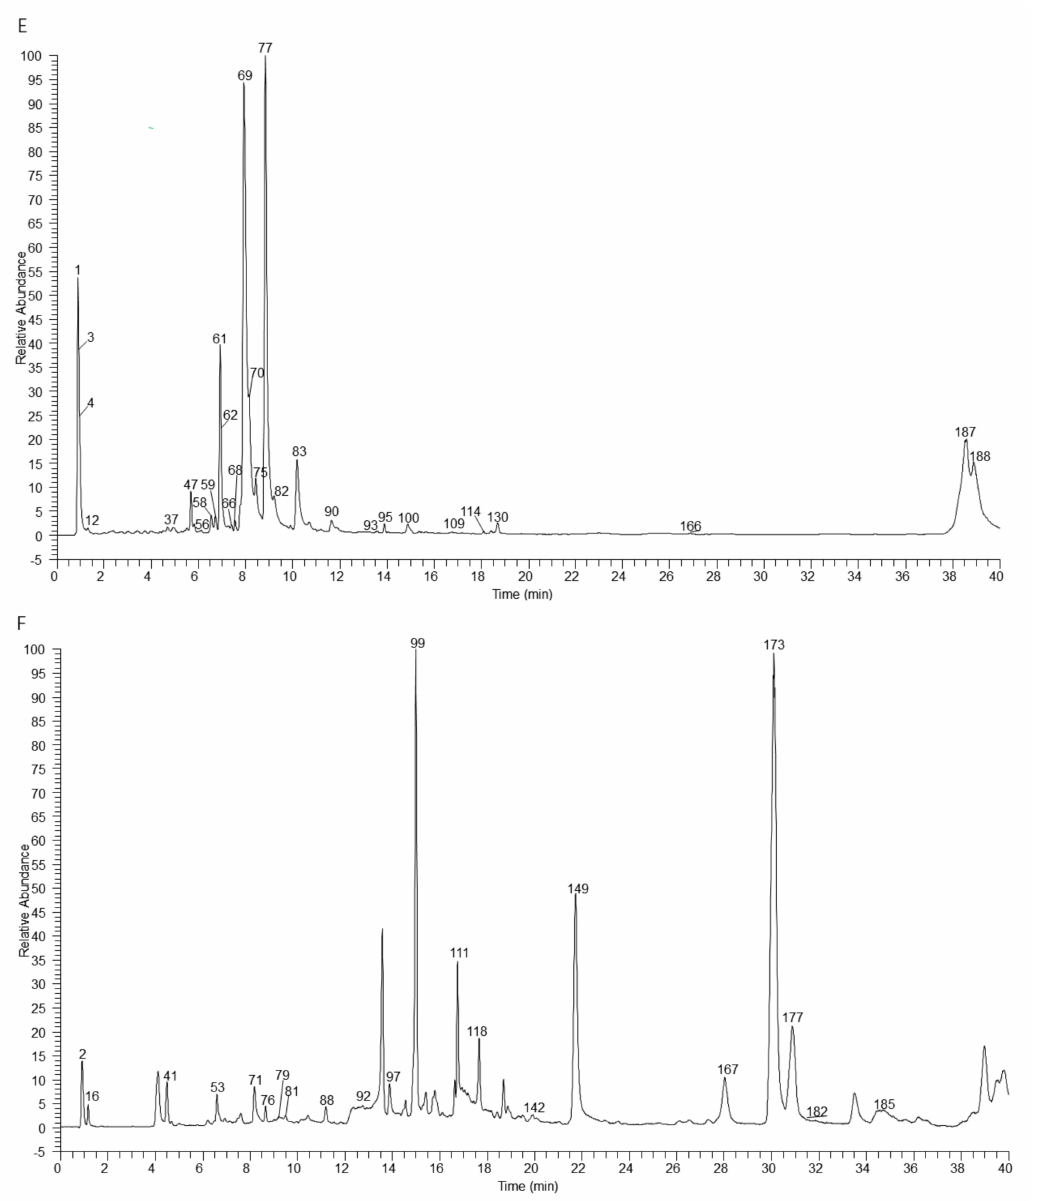
Figure 2. The high-resolution extracted ion chromatogram (HREIC) in 10 ppm for multiple com- pounds in Arnebiae Radix . ( A ) m / z 313.07176, 131.04621, 145.06186, 503.16175, 191.05611, 149.04554, 177.04046, 147.02989, 243.06225, 731.16175, 493.11402, 357.06159, 201.11323, 253.08701, 315.12379, 299.05611, 583.25620, 175.06119, 153.01933, 188.03531, 172.09791, 151.04006, 193.05063,